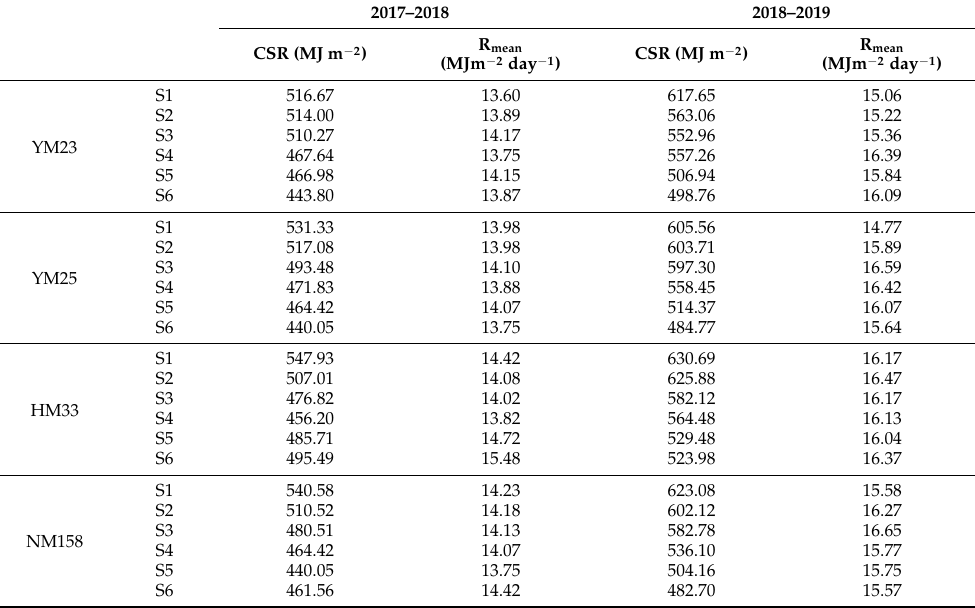
Table 2. Effects of different treatments on post-anthesis